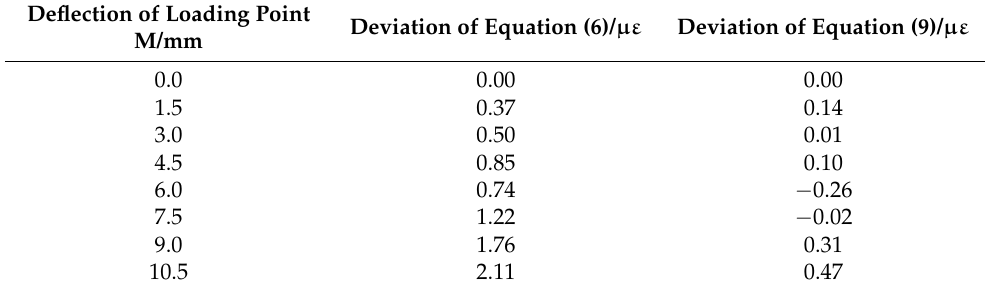
Table 5. Differences between strain gage measurements and calculated results in Equations (6) and